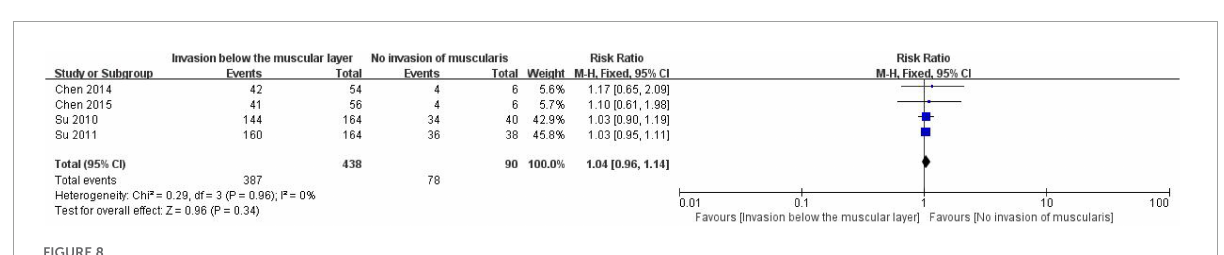
FIGURE8 Forest map related to CD24 expression and infiltration